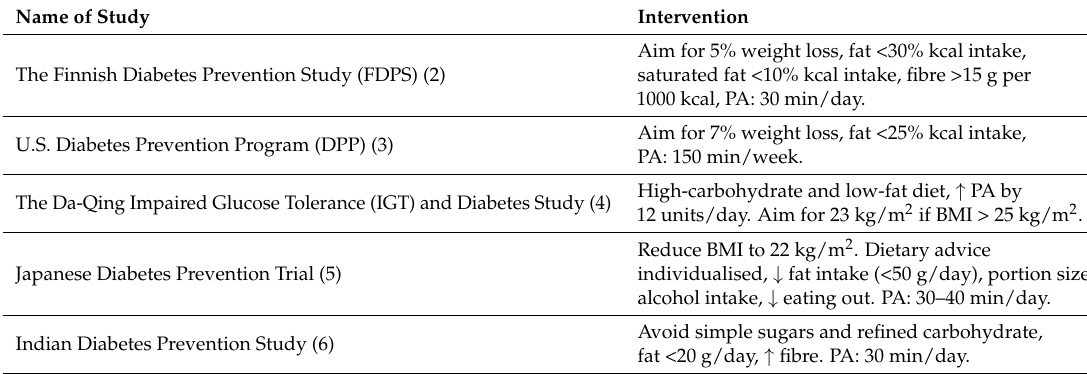
Table 1. Brief description of the dietary and lifestyle changes included in the major type 2 diabetes prevention trials.